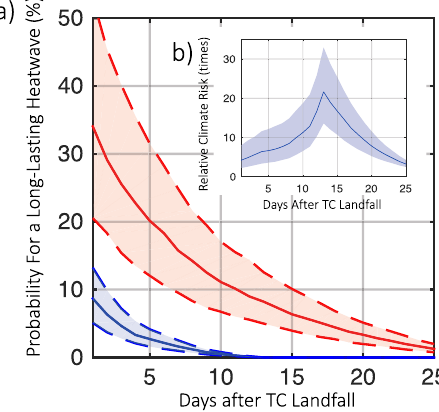
Fig. 2 | Analysis of likelihood and duration of post-TC heatwaves for Harris County. a Probability for a post-TC heatwave lasting over a certain duration in the historicalclimate(bluecurveshowingmedian,with32to68%quantilerangeshown by shade) and future climate (red curve showing median, with 32 to 68% quantile range shown by shade). b Relative climate risk, de fi ned as the ratio of future probability and historical probability of post-TC heatwave, as a function of heat- wave duration (shade shows 32 to 68% quantile